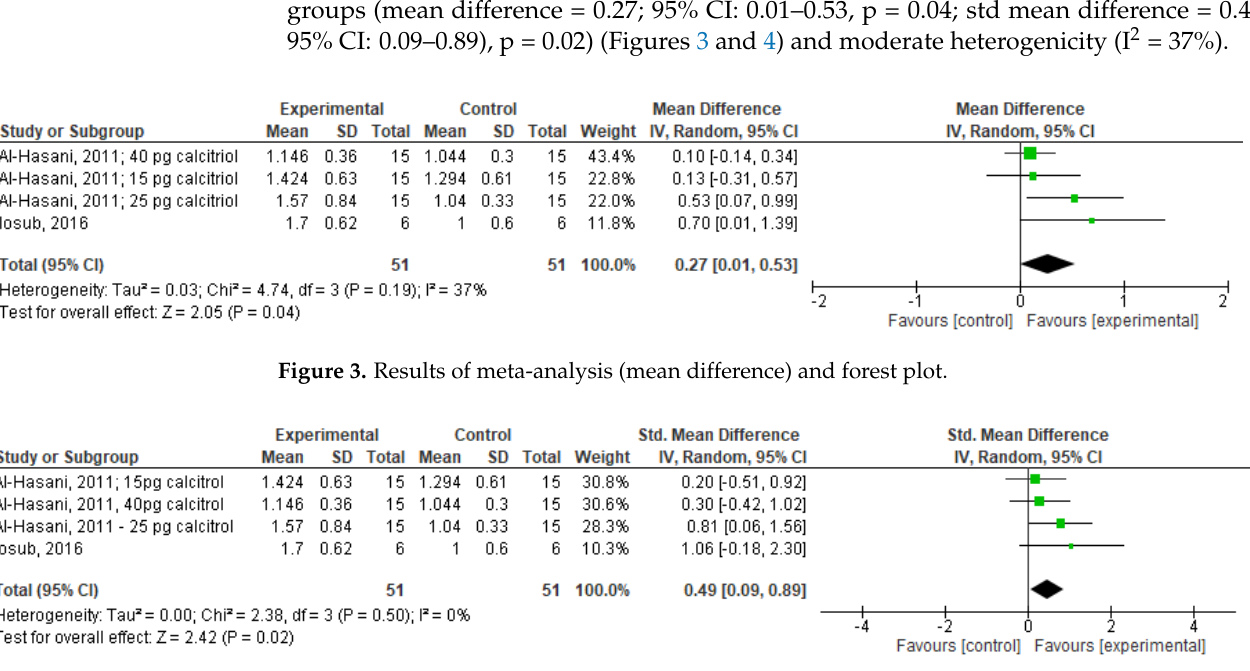
Figure 4. Results of meta-analysis (std mean difference) and forest plot.